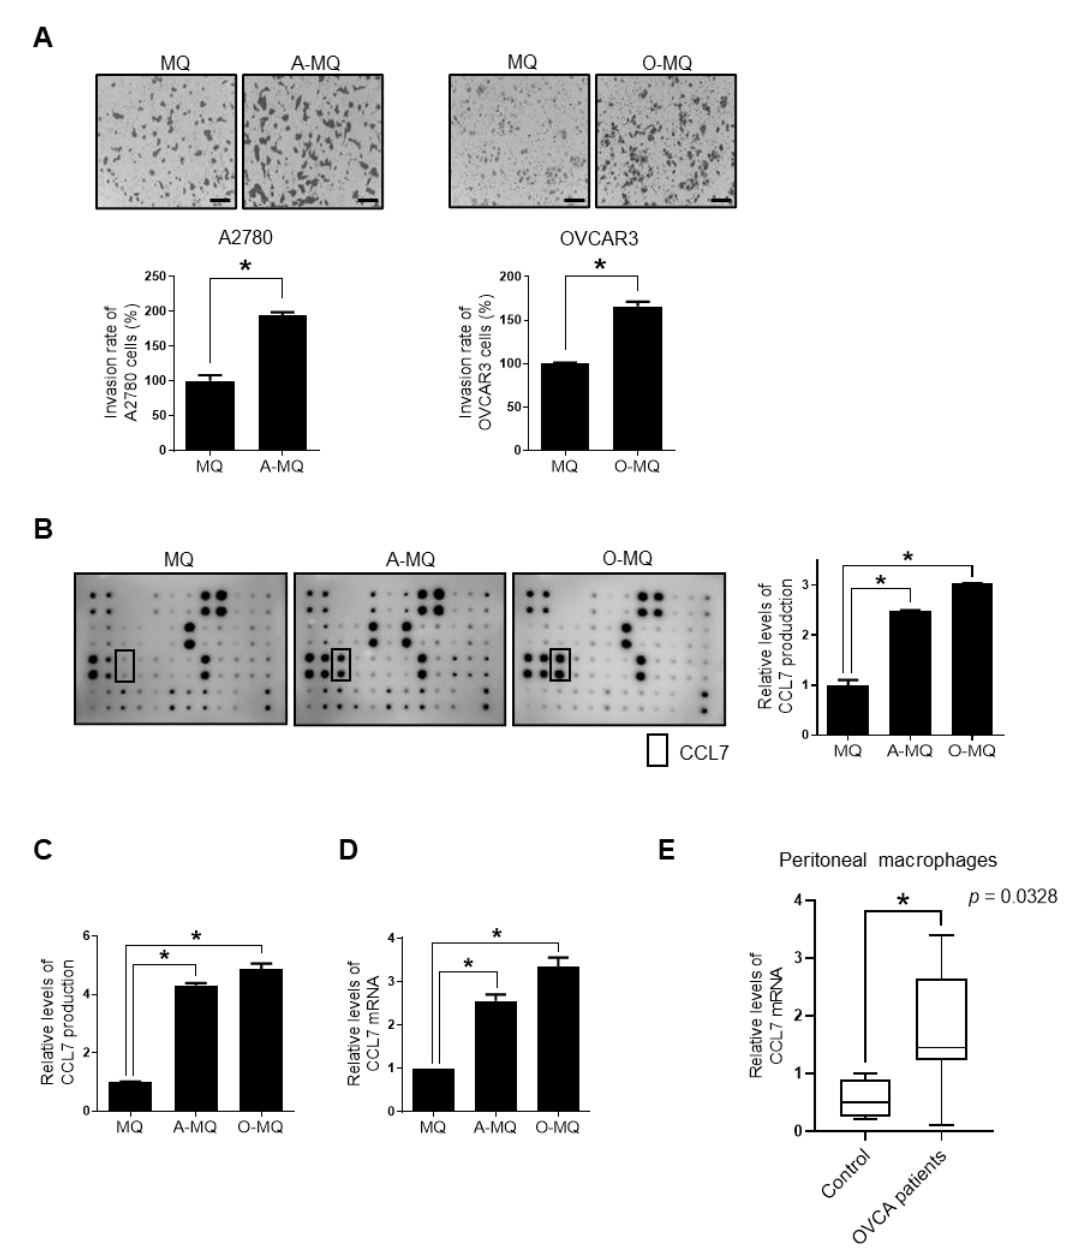
Figure 1. Increased expression of CC chemokine ligand 7 (CCL7) in macrophages stimulated by ovarian cancer cells. ( A ) Human ovarian A2780 and OVCAR3 cancer cells were resuspended with the conditioned medium of macrophages (MQ), macrophages stimulated by A2780 cells (A-MQ), and macrophages stimulated by OVCAR3 cells (O-MQ), and seeded in Matrigel-coated upper chambers. The cells were allowed to invade for 48 h. Scale bar, 100 µm. ( B ) A cytokine antibody array was used to analyze the cytokine profiles of the conditioned medium of MQ, A-MQ, and O-MQ. Values from the cytokine array membrane were evaluated by densitometry. ( C ) CCL7 production from MQ, A-MQ, and O-MQ was analyzed by ELISA kits. ( D ) The expression of CCL7 in MQ, A-MQ, and O-MQ was measured by the real-time polymerase chain reaction. ( E ) The expression of CCL7 in peritoneal macrophages of women with non-malignant tumors (control) and advanced ovarian cancer (OVCA). * p < 0.05.